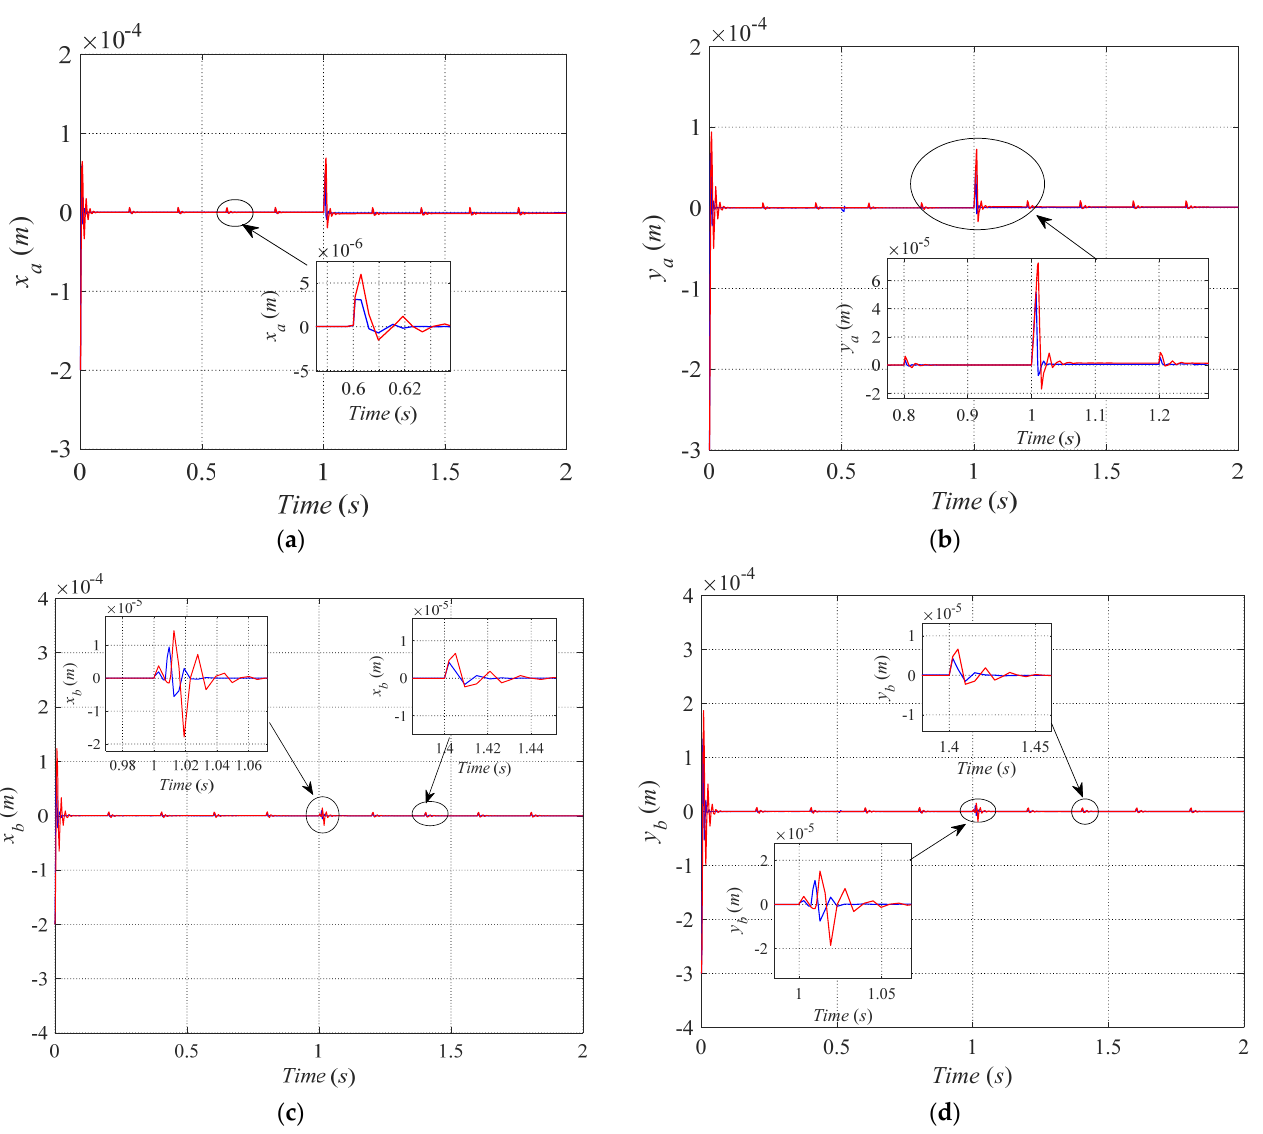
Figure 11. The rotor’s disturbance recovery performance under existing fault-tolerant control by red curve and in this paper by the blue curve. The trajectories of x a , y a, x b and y b are respectively illustrated in ( a – d ) that the periodic pulse disturbance is considered.